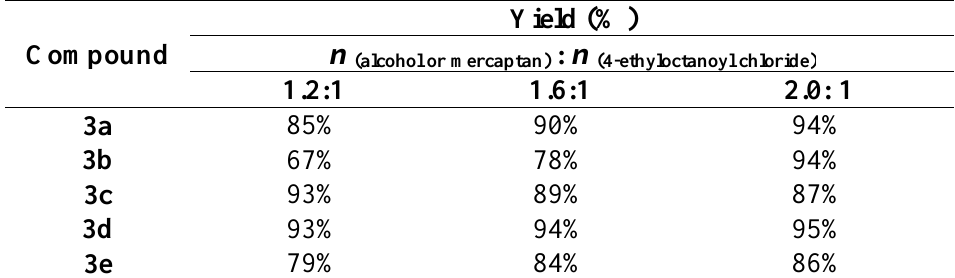
Table 1. Effect of different mole ratio of materials on the